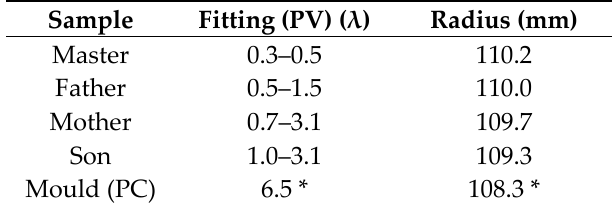
Table 1. Replication accuracies of a concave master within each generation.